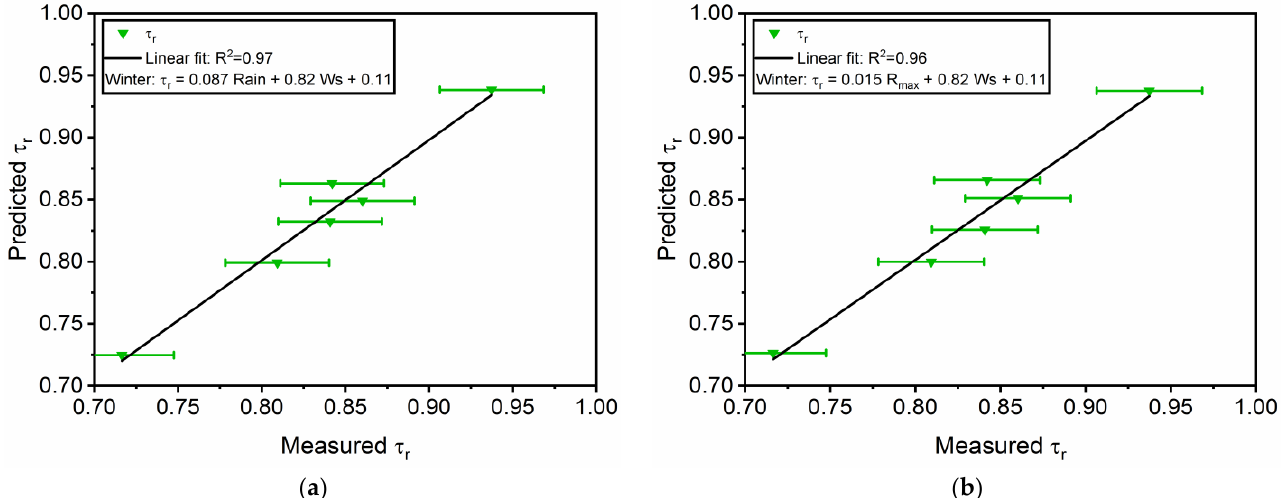
Figure 12. Regression plot of predicted transmittance and measured transmittance of weekly cleaned glass (G2) using the MLR model during the winter season for various environmental parameters: ( a ) Rain and Ws and ( b ) R max and Ws . The uncertainty associated with the average relative direct transmittance of the weekly cleaned glass coupon during winter is ±0.031.